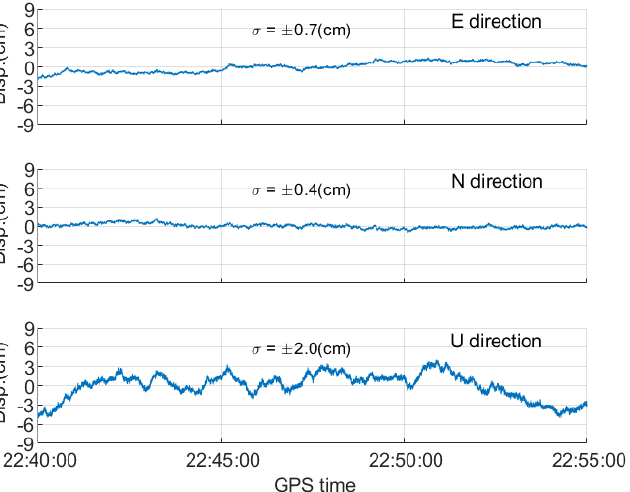
Figure 9. Vibrational displacements at station NCCU in 22:40–22:55 (GPS time). The five-constellation PPP is adopted during the process.